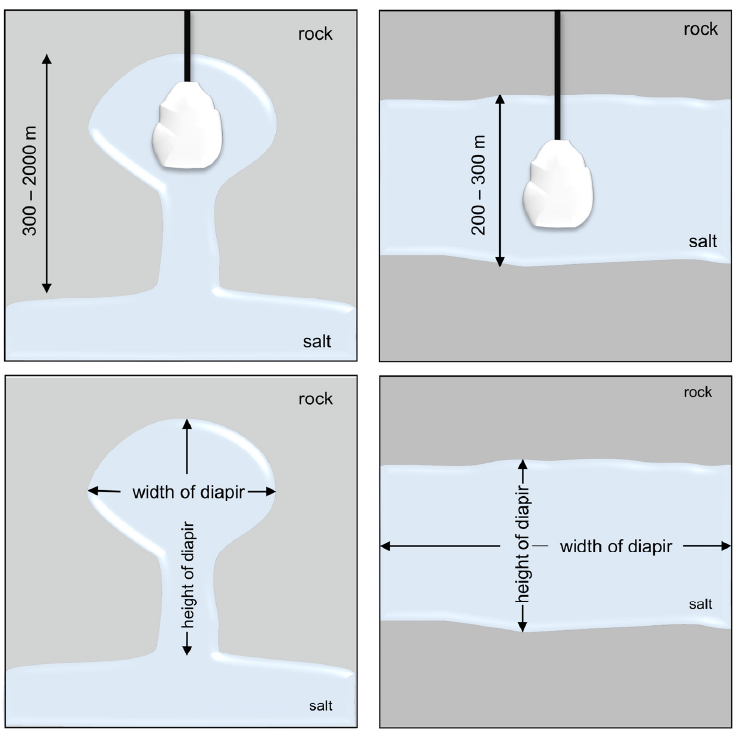
Figure 2. Salt caverns in diapiric deposits ( left ) and salt layers ( right ) .